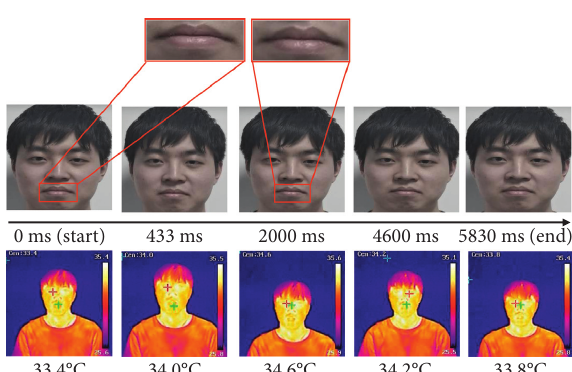
Figure 1: Changes in microexpressions after TIM treatment and corresponding temperature and expression